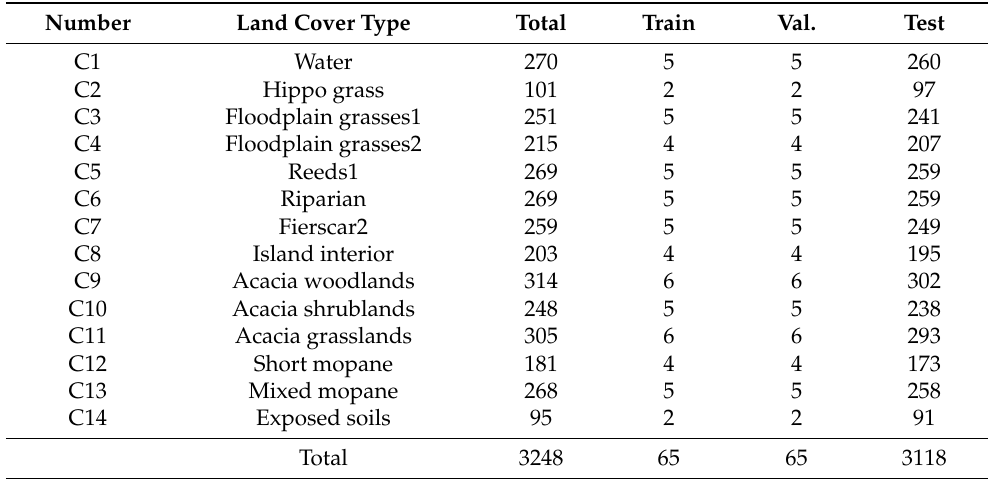
Table 8. The number of total samples, training samples, validation samples, and testing samples for each category of the BS dataset.